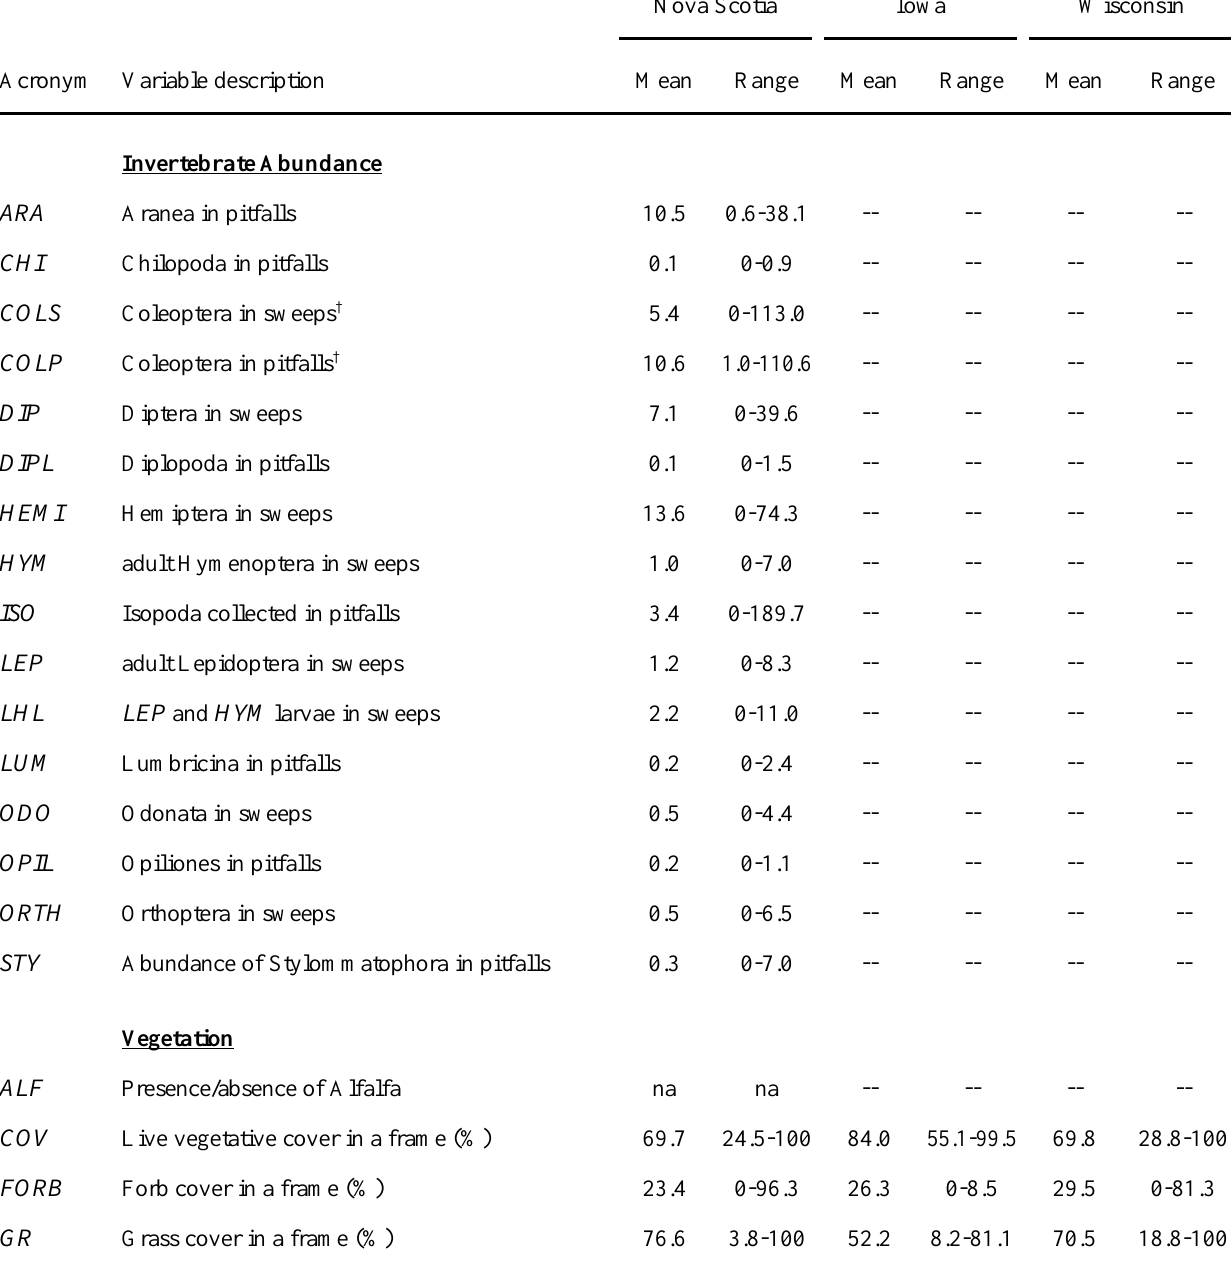
Table 1. Predictive variables used in modeling, acronyms, and data summaries. Sample point mean and range for each study area are shown as years combined. Abundance of insect orders is expressed as catch- per-unit-effort; all other variables show units in parentheses. No artificial mean is derived for ordinal and binary variables, shown as "na." Variables not measured in Iowa and Wisconsin study areas are denoted by